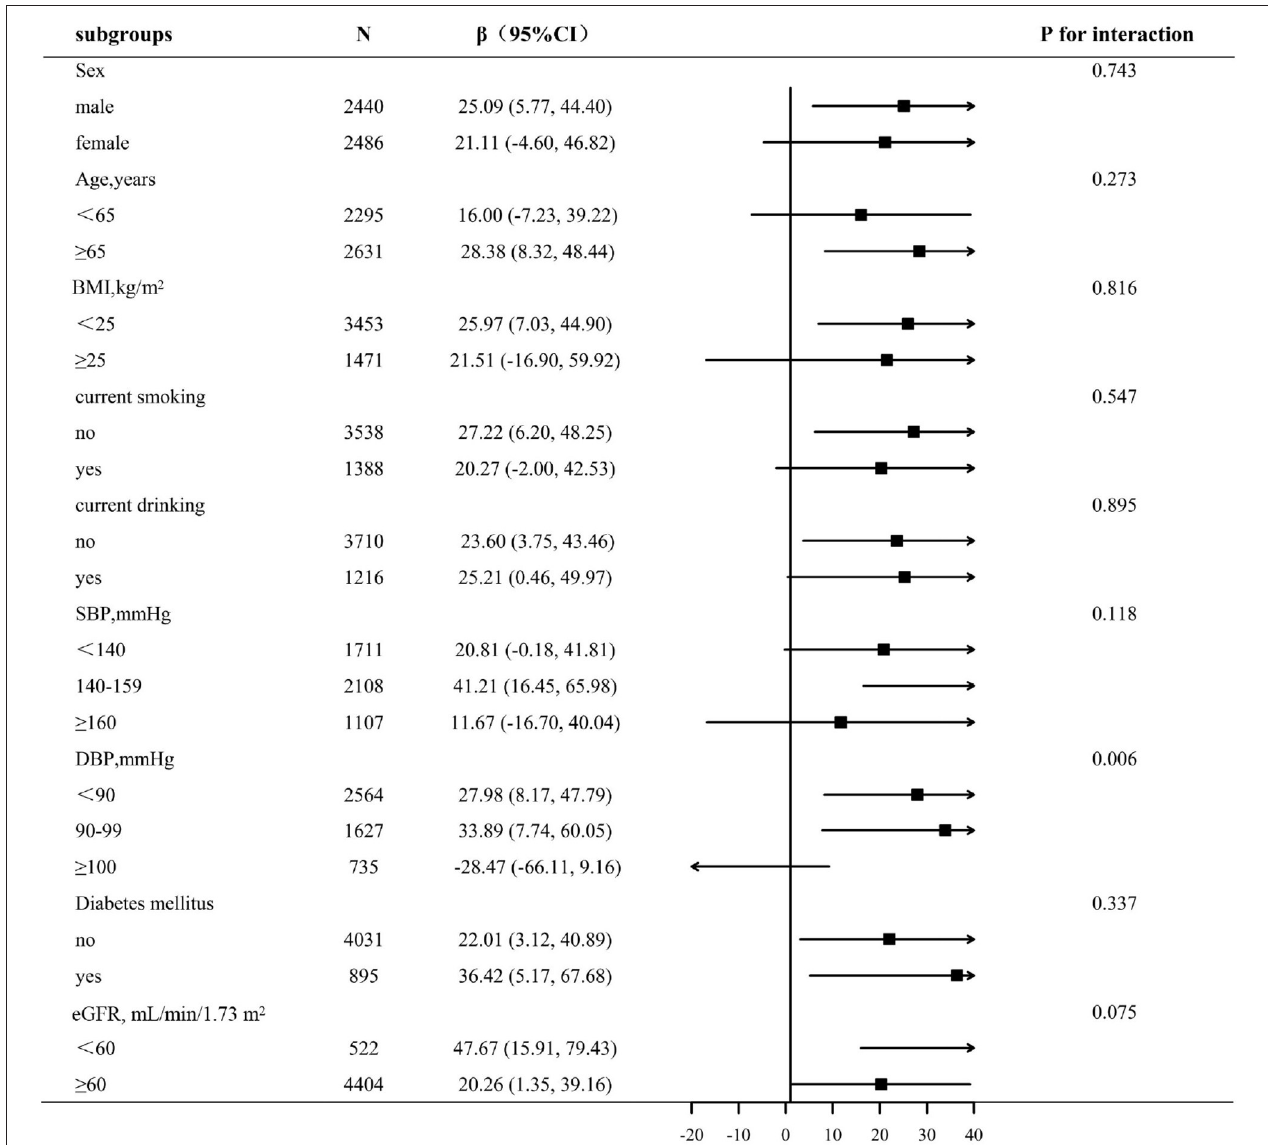
FIGURE 2 | Subgroup analyses by potential effect modifiers. *Each subgroup analysis adjusted, if not stratified, for age, sex, BMI, SBP, DBP, pulse rate, pulse pressure, smoking status, drinking status, FBG, TC, HDL, LDL-C, Hcy, uric acid, eGFR, diabetes mellitus, antihypertensive drugs, antiplatelet drugs, the types of antihypertensive drugs, duration of hypertension, and glucose-lowering